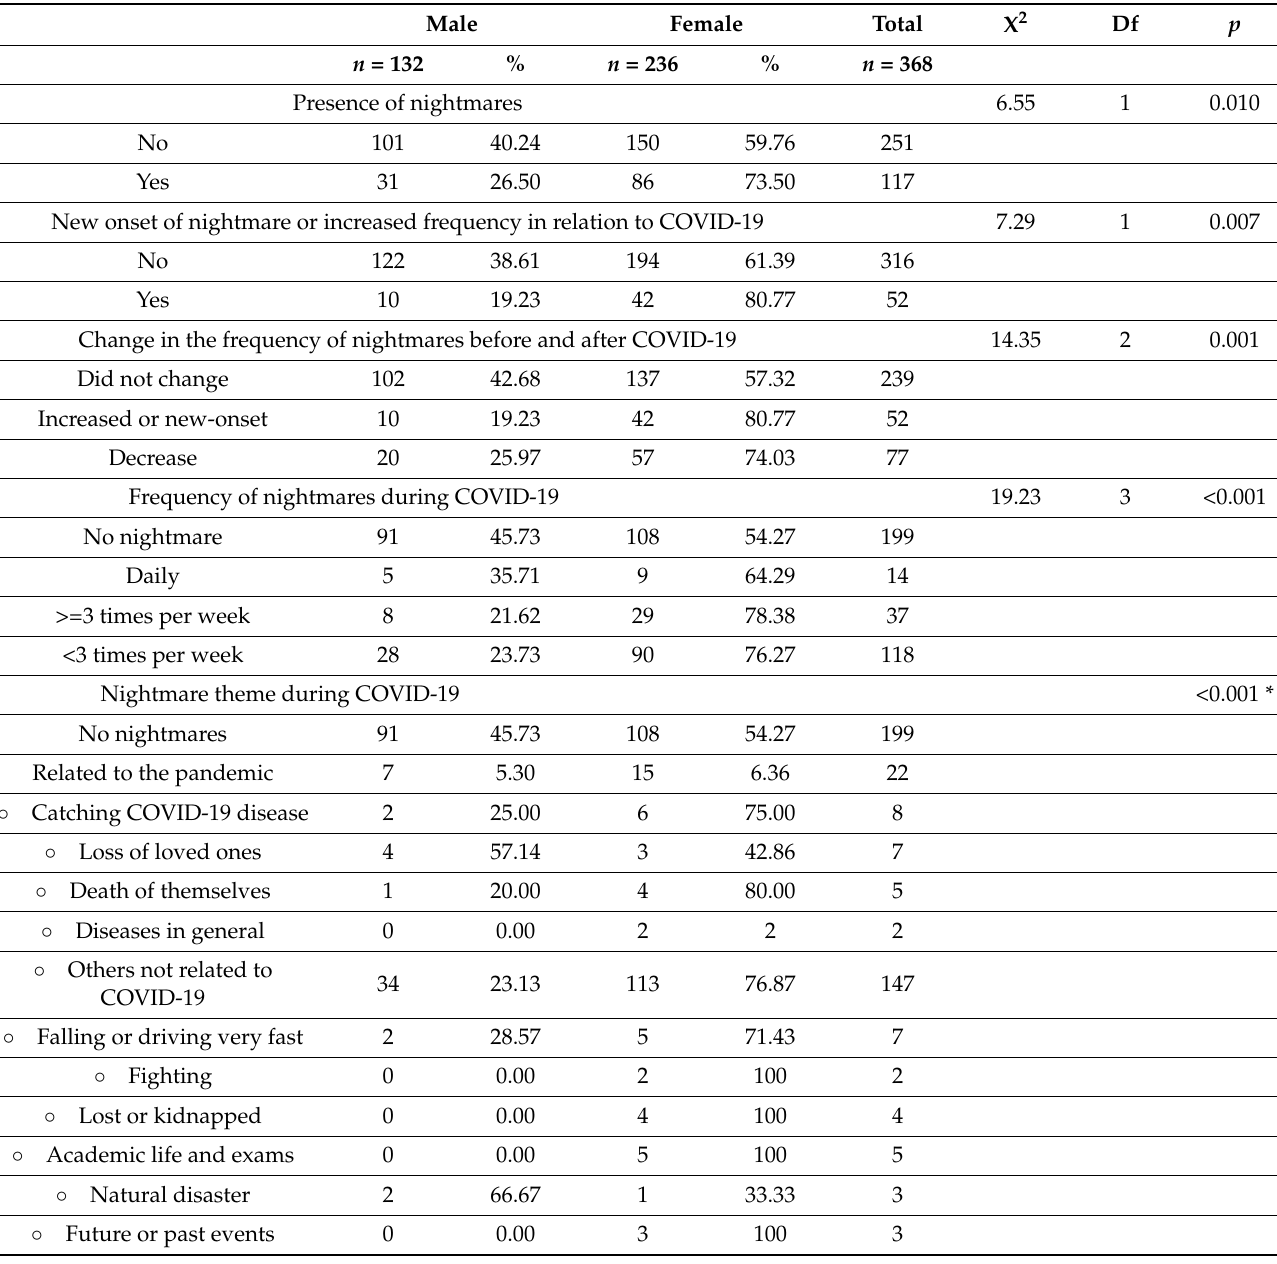
GSDS score. Table 3 summarize the distribution of GSDS components among males and females and nightmares. Table 2. Distribution of nightmare indicators amongst study participants concerning gender ( n =